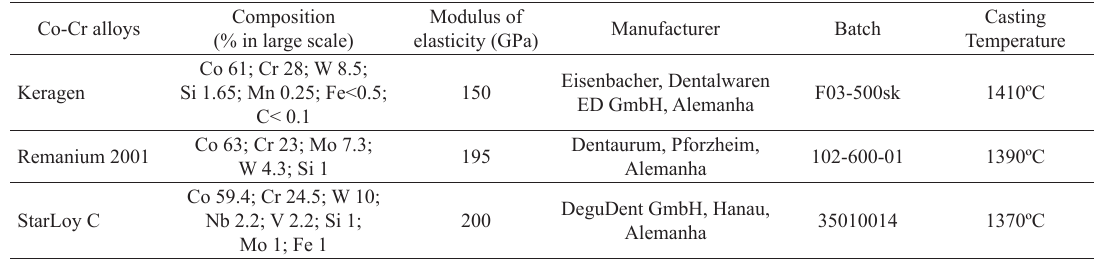
Table 1. Characteristics of Co-Cr dental alloys evaluated.